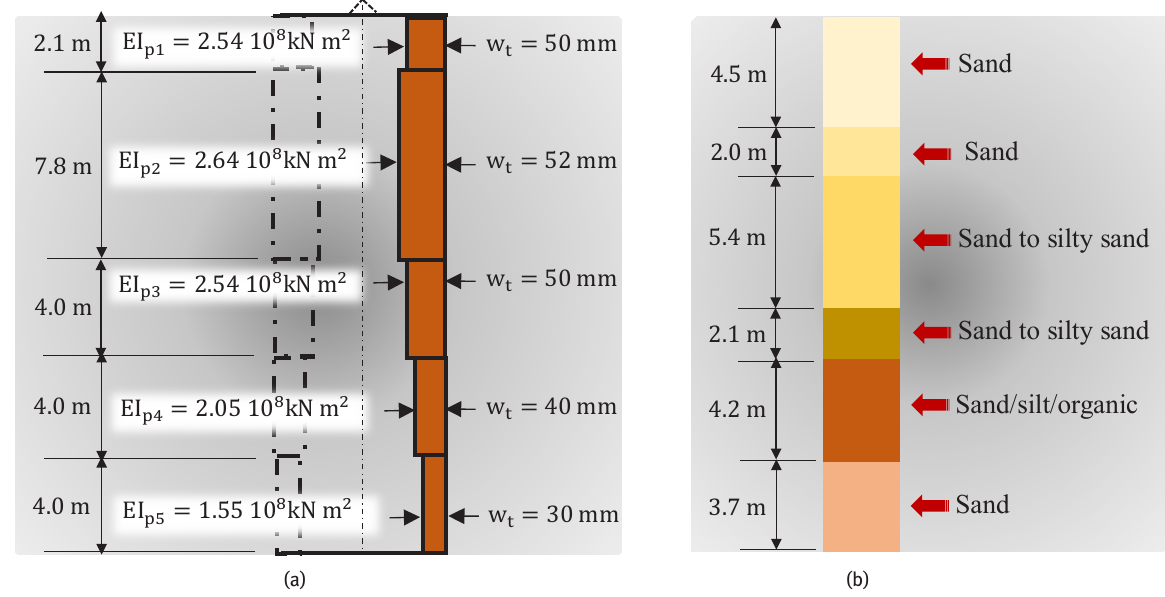
Figure 3: Monopile at Horns Rev: (a) monopile structural details, (b) soil